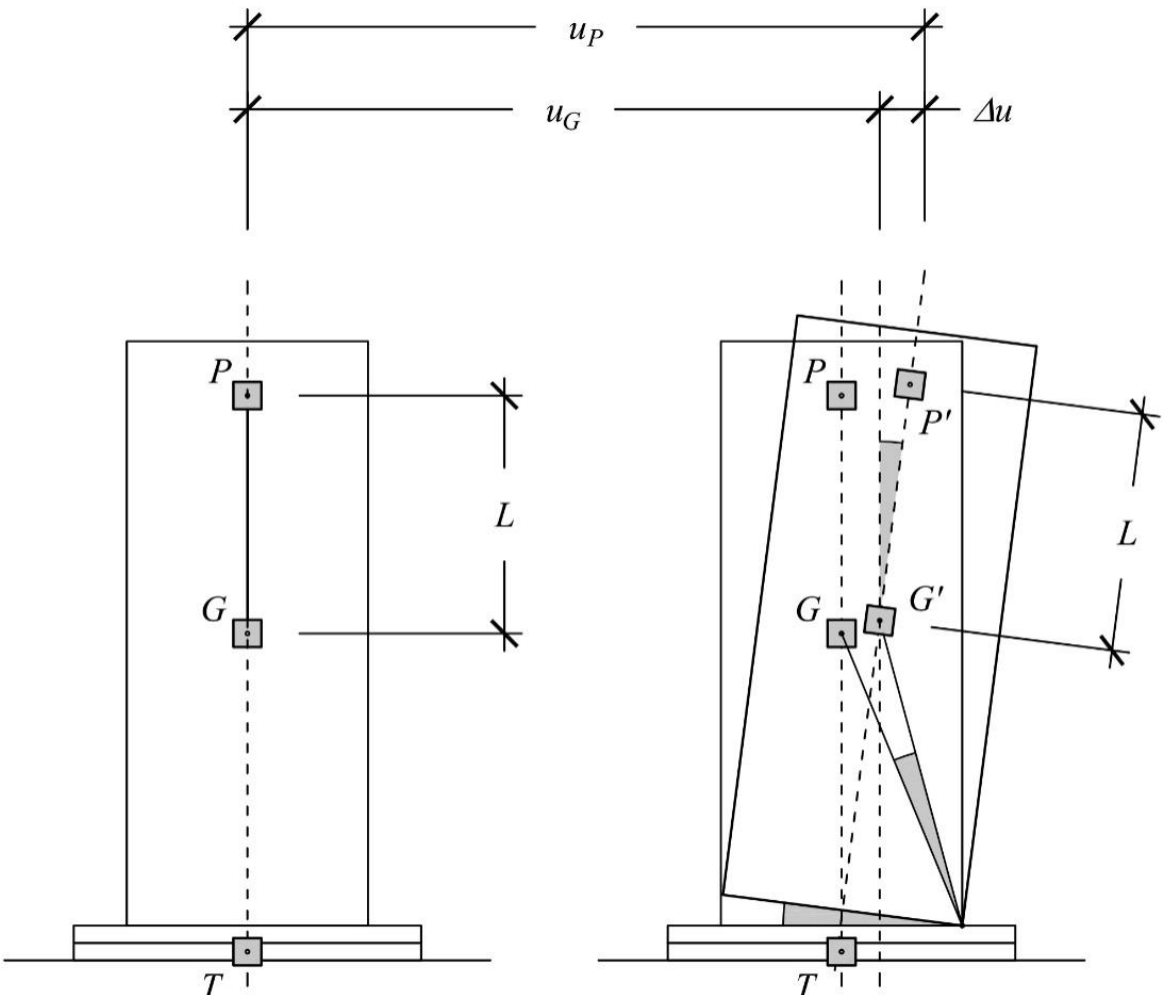
Figure 7. Relative displacement calculation: angle sizing for the free-standing block.